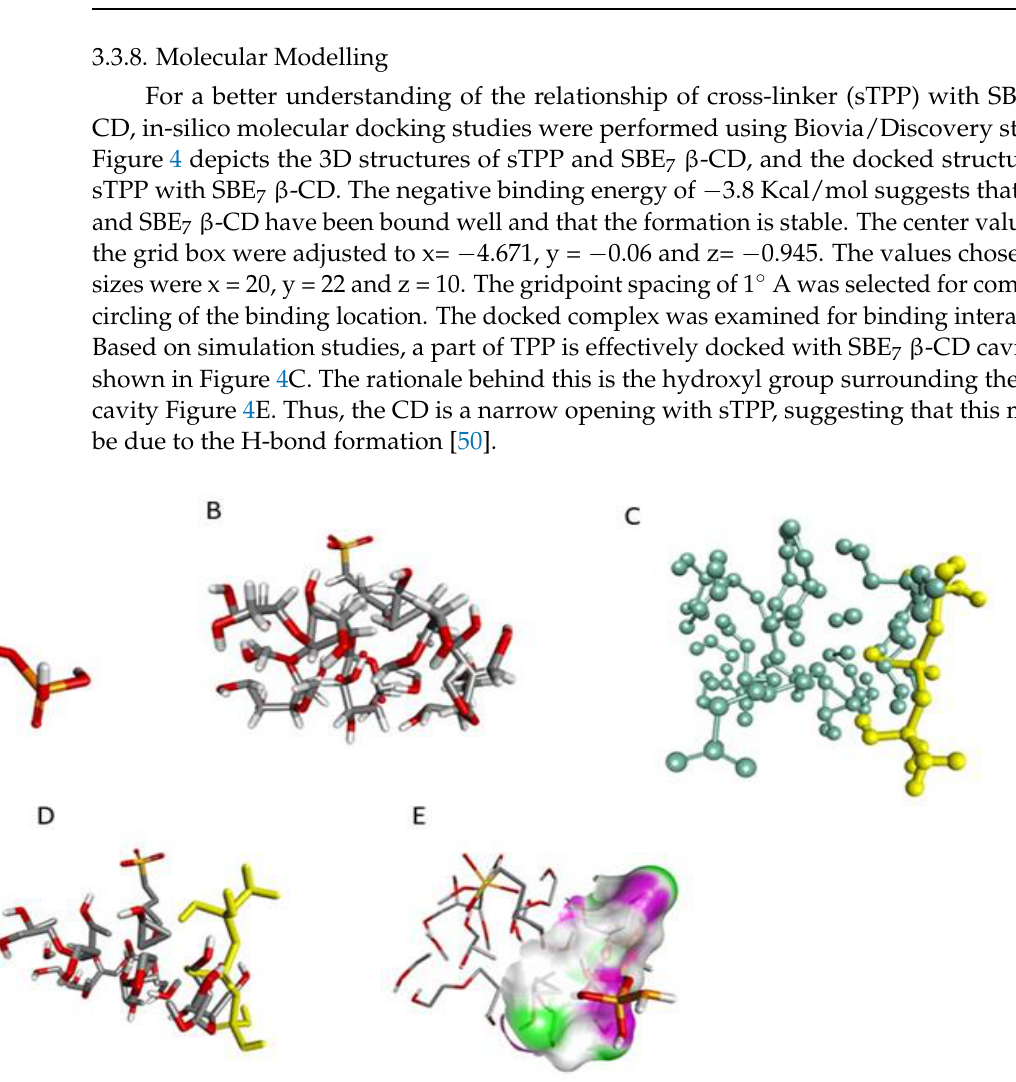
Figure 4. 3D structure of ( A ) TPP, ( B ) SBE 7 β -CD, ( C ) Stick-ball structure of SBE 7 β -CD and TPP, ( D ) Docked structure of ligand and receptor, ( E ) , H —bonding.